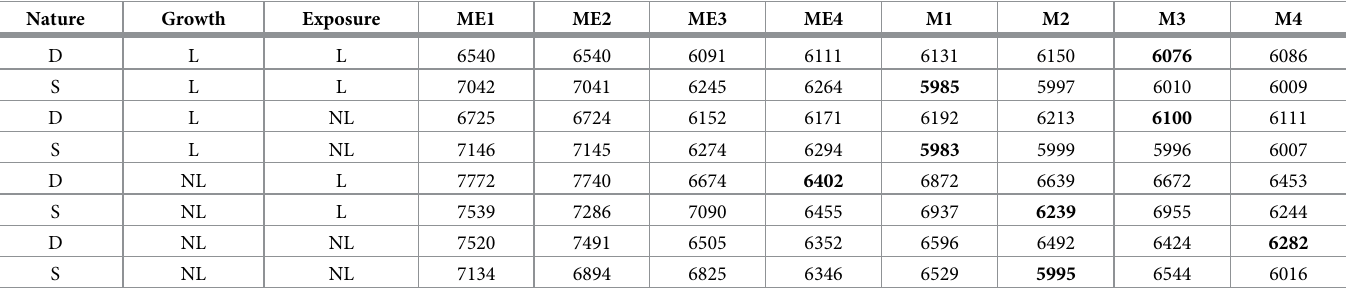
ME, Mixed Effect Model; M, Growth Mixture Model; D, Deterministic; S, Stochastic; L, Linear; NL, Non-Linear Models 1, 3 assume linear mean; Models 2, 4 assume quadratic mean.